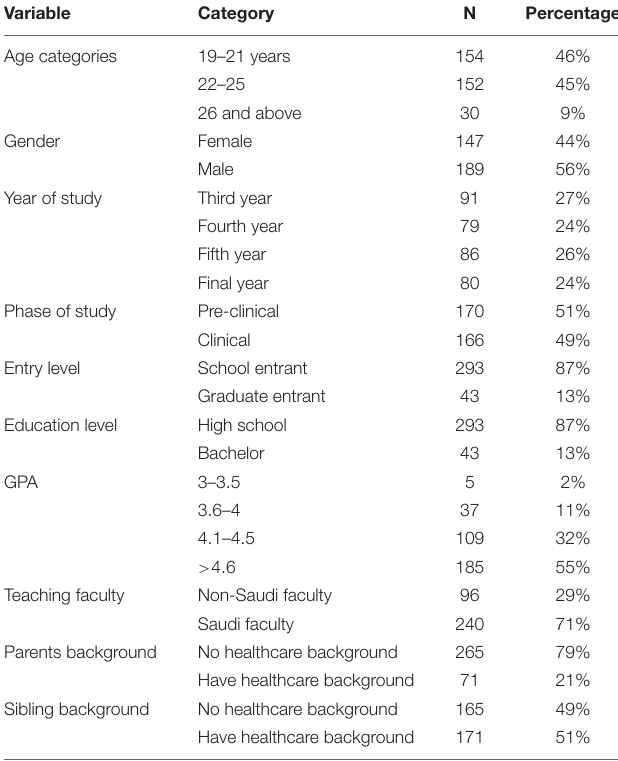
TABLE 1 | Profile of participants ( n =